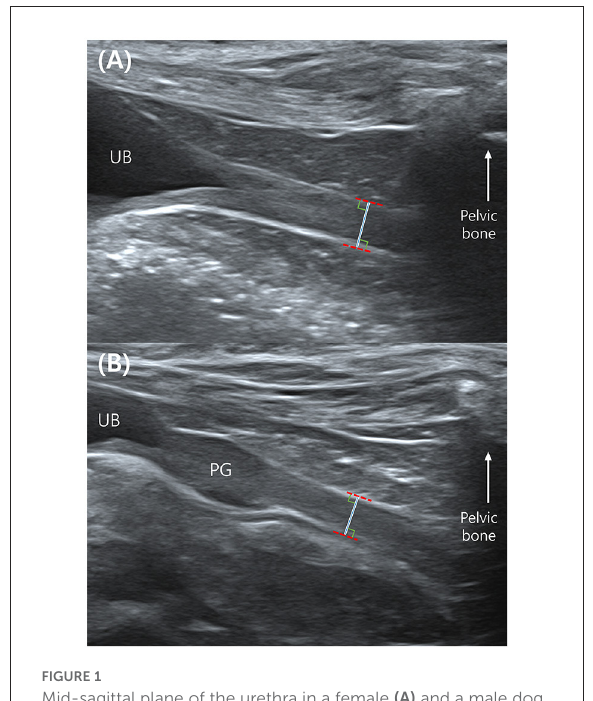
FIGURE1 Mid-sagittal plane of the urethra in a female (A) and a male dog (B) in ultrasonography. The total urethral thickness is measured directly in front of the pelvic bone which makes acoustic shadowing. The measurement is made with the leading edge to the trailing edge. UB, urinary bladder; PG, prostate gland.